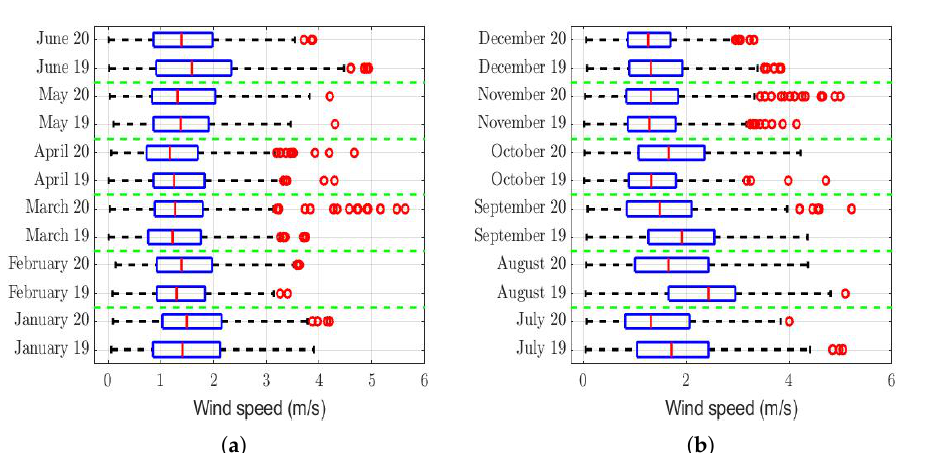
Figure 4. Box plot of the wind speed (m/s): 2019 vs. 2020. The red circles represent the outliers.